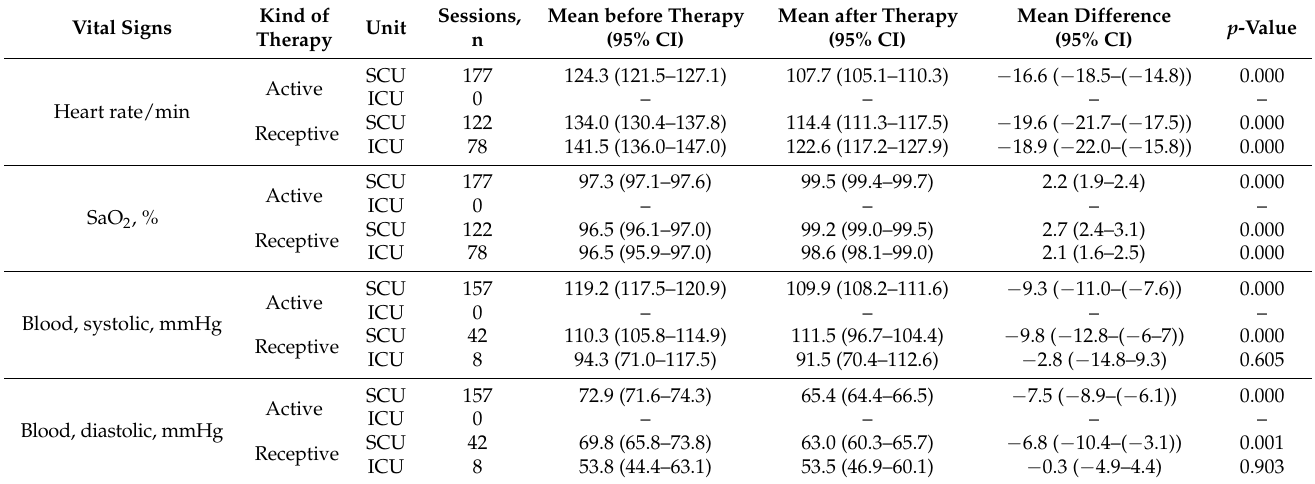
Table 6. Heart rate, oxygen saturation and blood pressure before and after active and receptive music therapy sessions at the SCU and